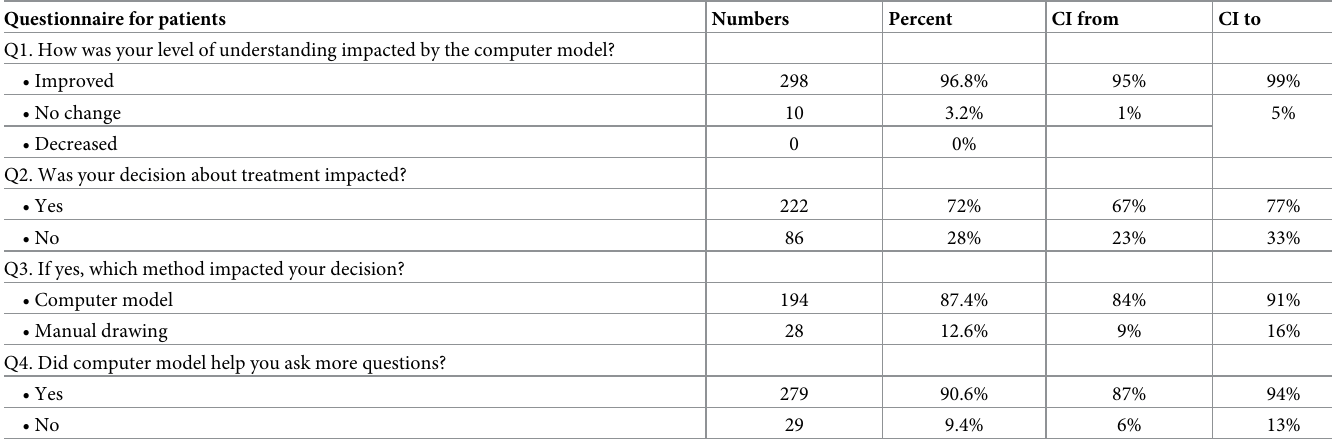
Table 1. Questionnaire for patients (with 95% confidence intervals (CI) from/to). Questionnaire for patients